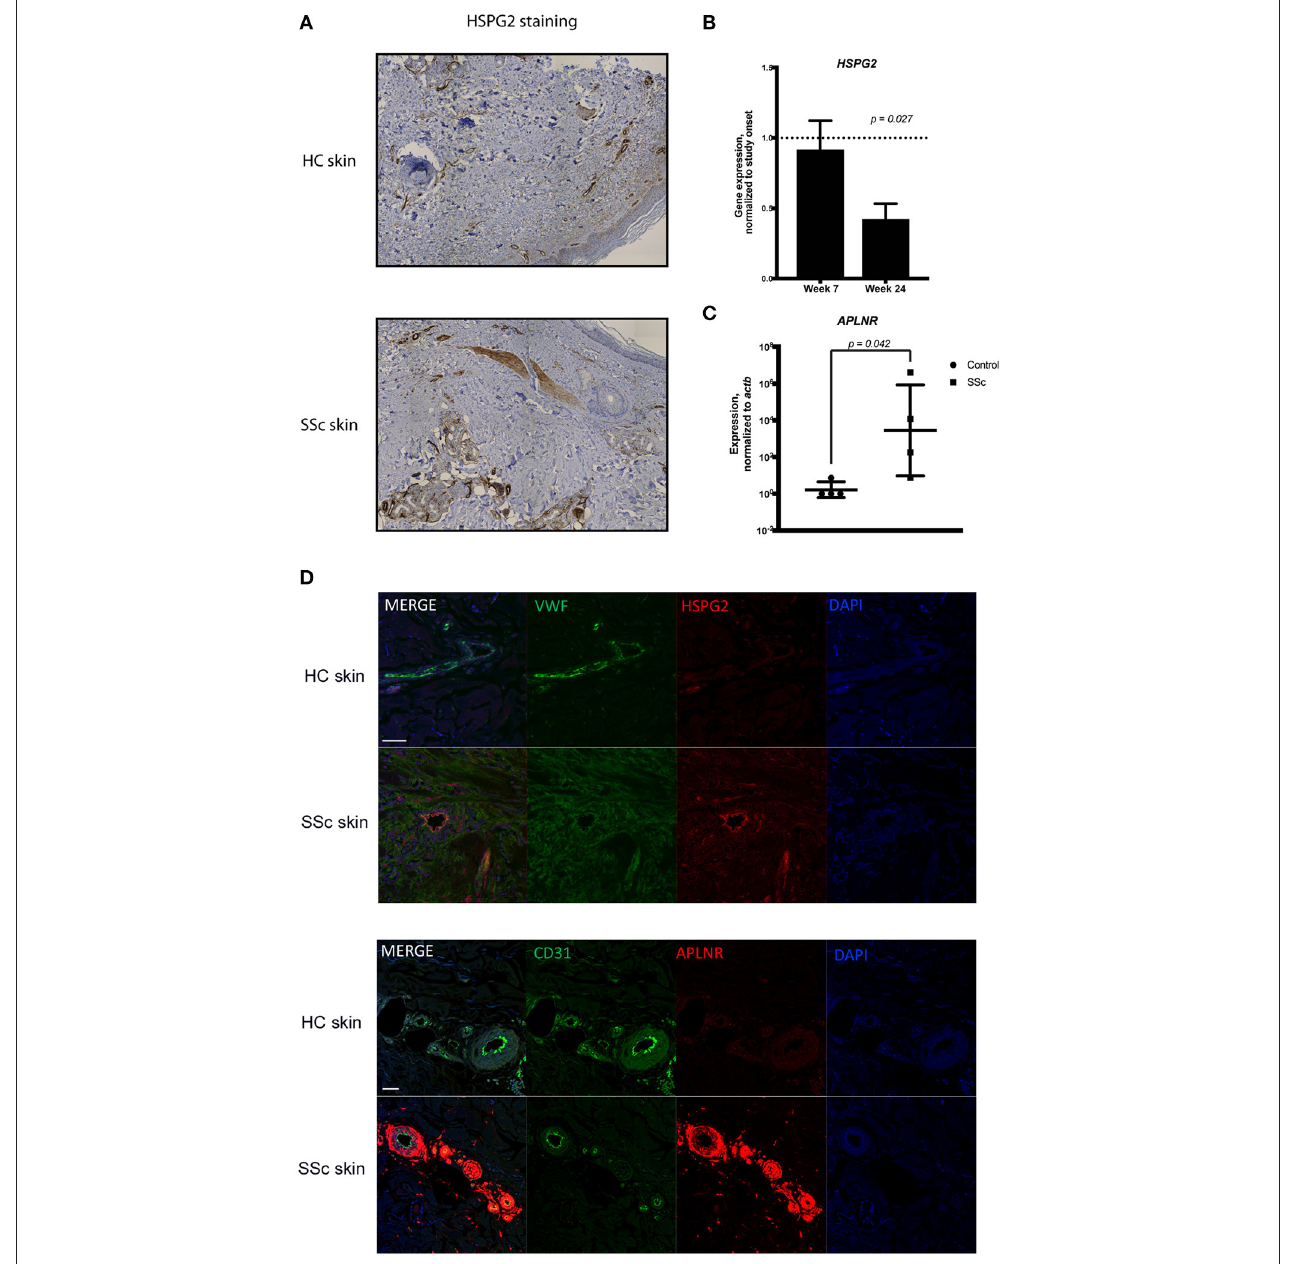
FIGURE 5 | (A) Immunohistochemistry of skin biopsies from healthy and SSc skin showing the expression of HSPG2. (B) The microarray data from the Fresolimumab clinical trial were analyzed to show the expression of HSPG2 gene within the study subjects during treatment with fresolimumab at week 7 and week 24. Expression levels are normalized to the onset of study at the time of enrollment. Data were analyzed using ANOVA and shown is the p- value. (C) qPCR analysis of the expression of APLNR in MVECs isolated from healthy and scleroderma skin. Data are normalized to ACTB. t -test analysis was performed and the p -value is shown. (D) Dual antibody immunofluorescent (IF) staining of formalin fixed paraffin embedded scleroderma and control skin biopsies sectioned in 5 µ m sections. Upper panels show dual IF staining of HSPG2 (green) and Von Willebrand factor (red) co-localizing on blood vessels. Lower panels show dual IF staining of Von Willebrand factor (green) and APLNR (red) co-localizing on blood vessels in scleroderma skin with DAPI nuclear stain. Scale bar = 50mm.